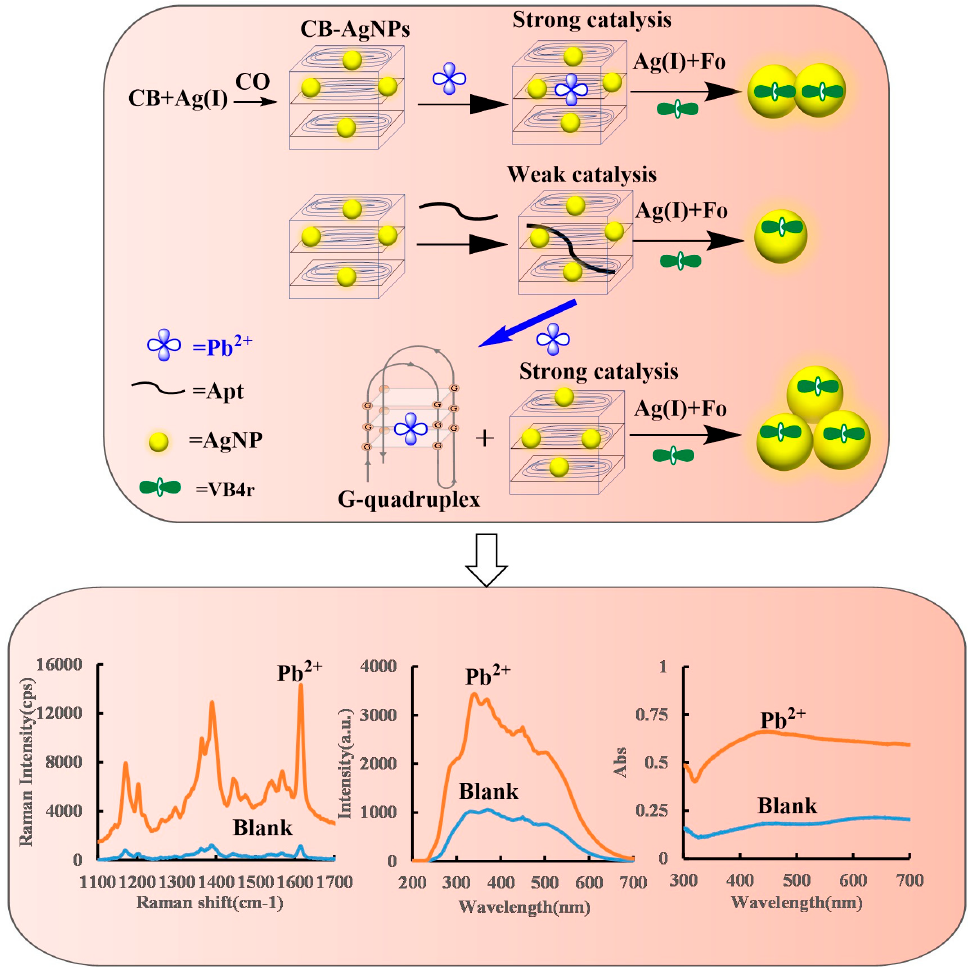
Figure 1. SERS/RRS/Abs trimode detection of inorganic pollutant Pb 2+ coupled with CB@AgNPs catalysis amplification with the Apt.